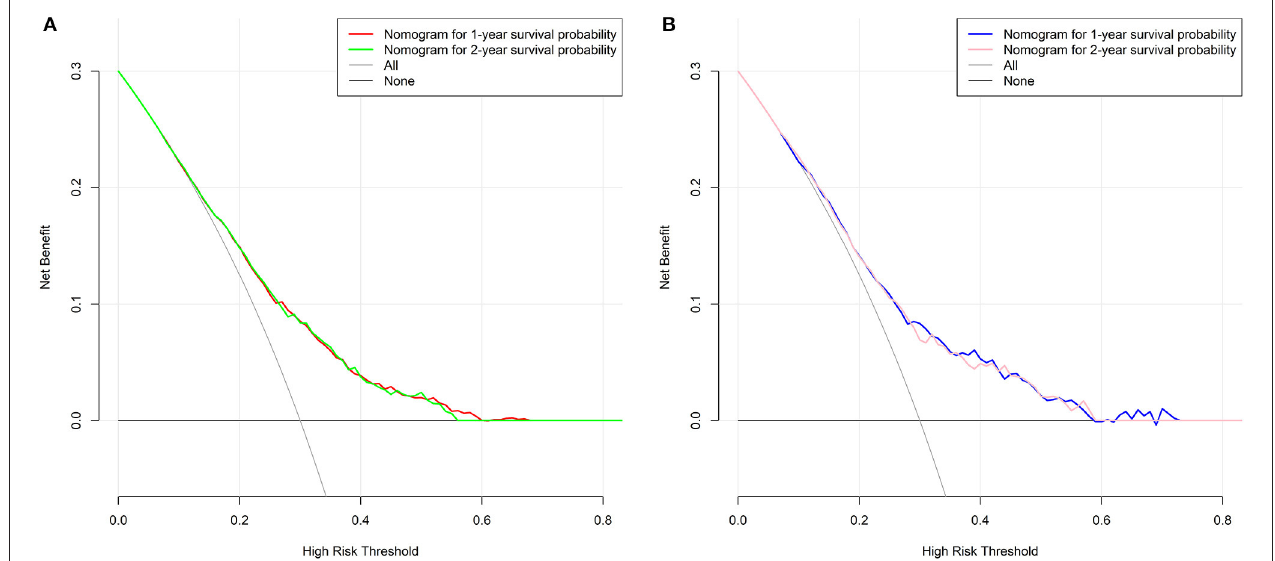
FIGURE 3 | Decision curves of the nomogram predicting 1 and 2-year OS in the (A) training group and (B) validation group, respectively.